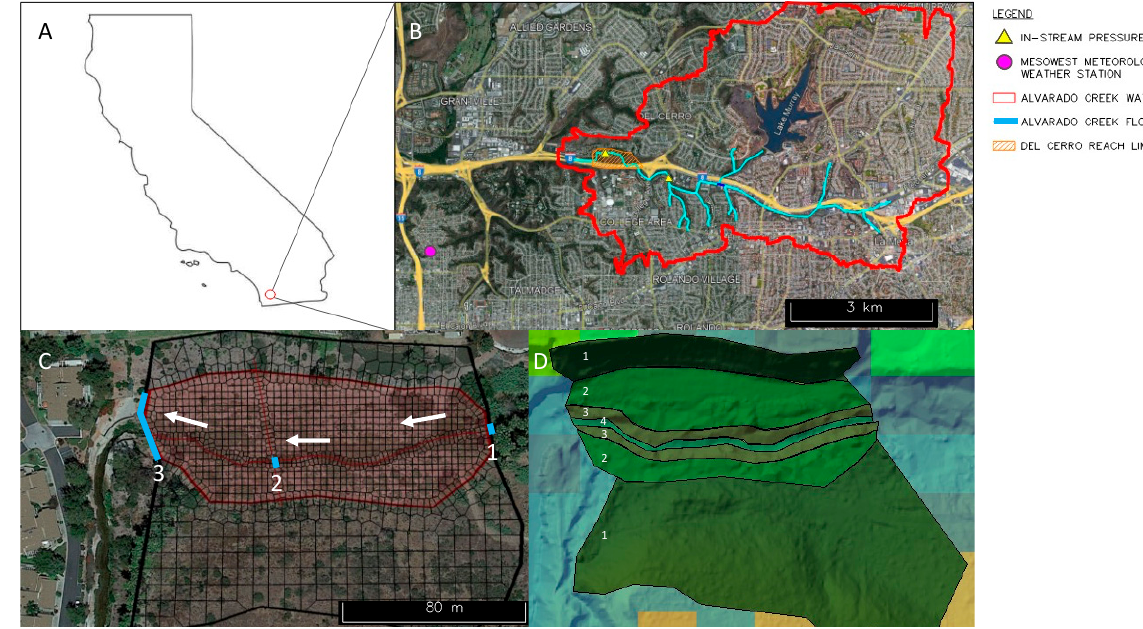
Figure 1. ( A ) Alvarado Creek is located in San Diego, California. ( B ) Data collection and modeling are concentrated in the Del Cerro reach within the Alvarado Creek watershed. The location of the in-stream pressure transducer and Mesowest meteorological station DW3640 are denoted by a yellow triangle and magenta circle, respectively. ( C ) A computational mesh for the Del Cerro reach was defined in HEC-RAS 2D. The refinement region is shaded in red, and three boundary condition lines (external inflow (1), an internal boundary condition (2), and outflow (3)) are denoted in blue. The white arrows indicate the direction of flow. ( D ) HEC-RAS 2D calibration regions (1 is hillside, 2 is floodplain, 3 is riparian zone, and 4 is the channel or open water).